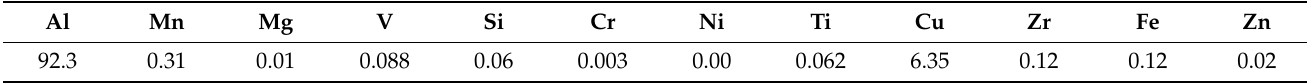
Table 2. Mechanical properties of workpiece material.